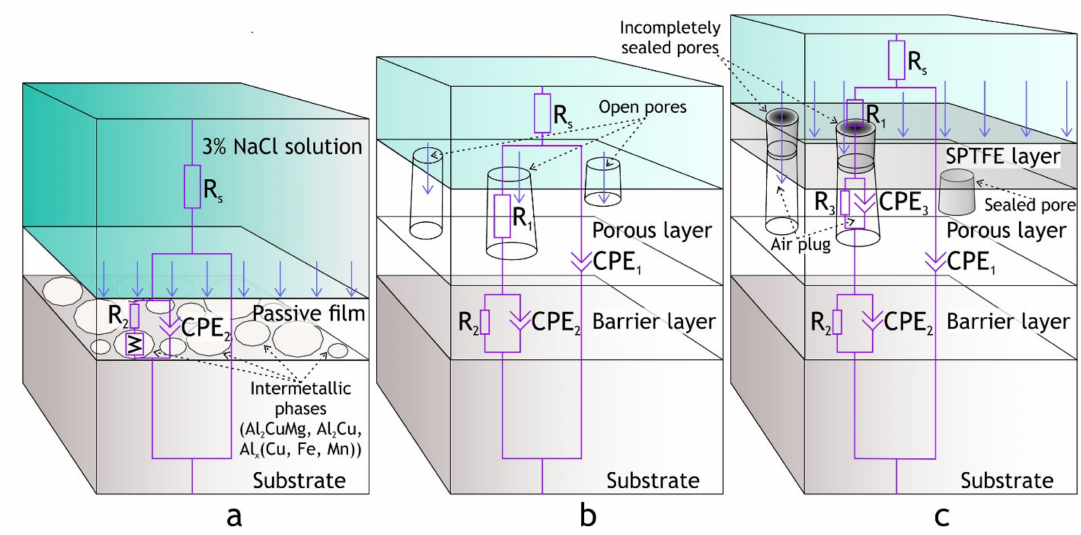
Figure 1. Equivalent electrical circuits used for the impedance spectra analysis: ( a ) Al-Cu-Mg aluminum alloy, ( b ) plasma electrolytic oxidation (PEO)-coating, ( c ) composite